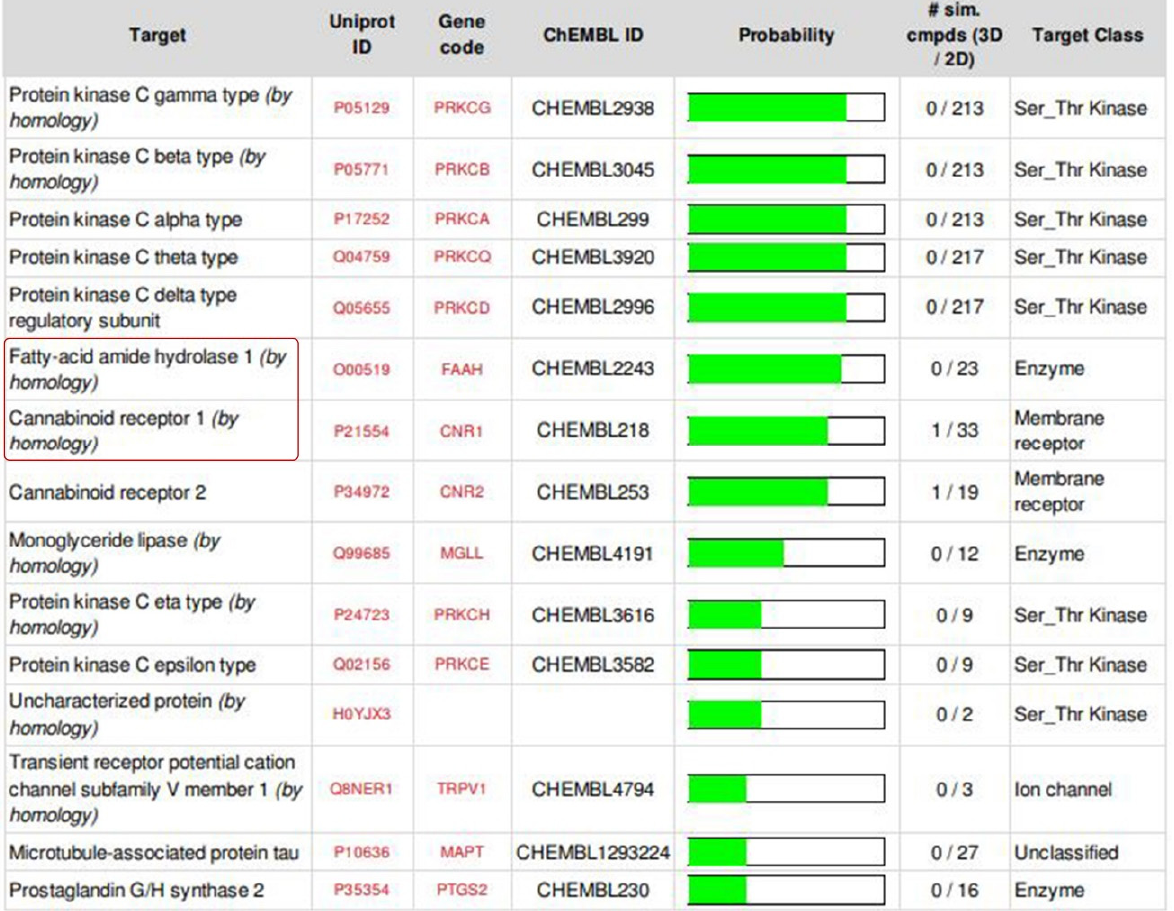
Figure 2. Select targets used for the present investigation (SwissTargetPrediction server (version 2014) http://old.swisstargetprediction.ch/ (accessed on 3 August